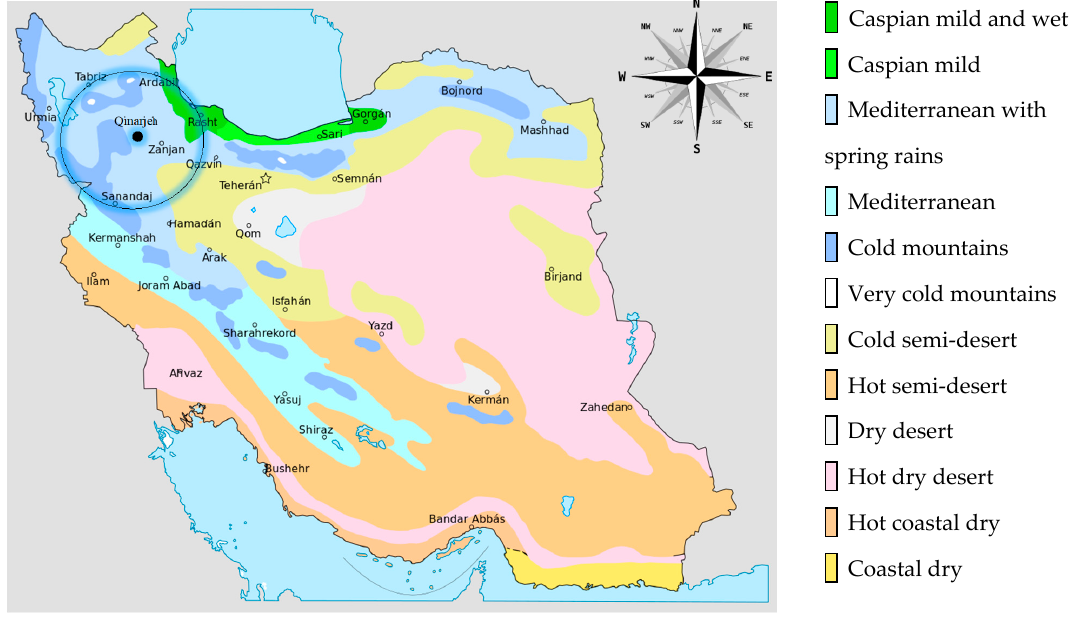
Figure 2. The satellite view of the center of Qinarjeh village (Google Maps 2019, Retrieved 13 February 2019)